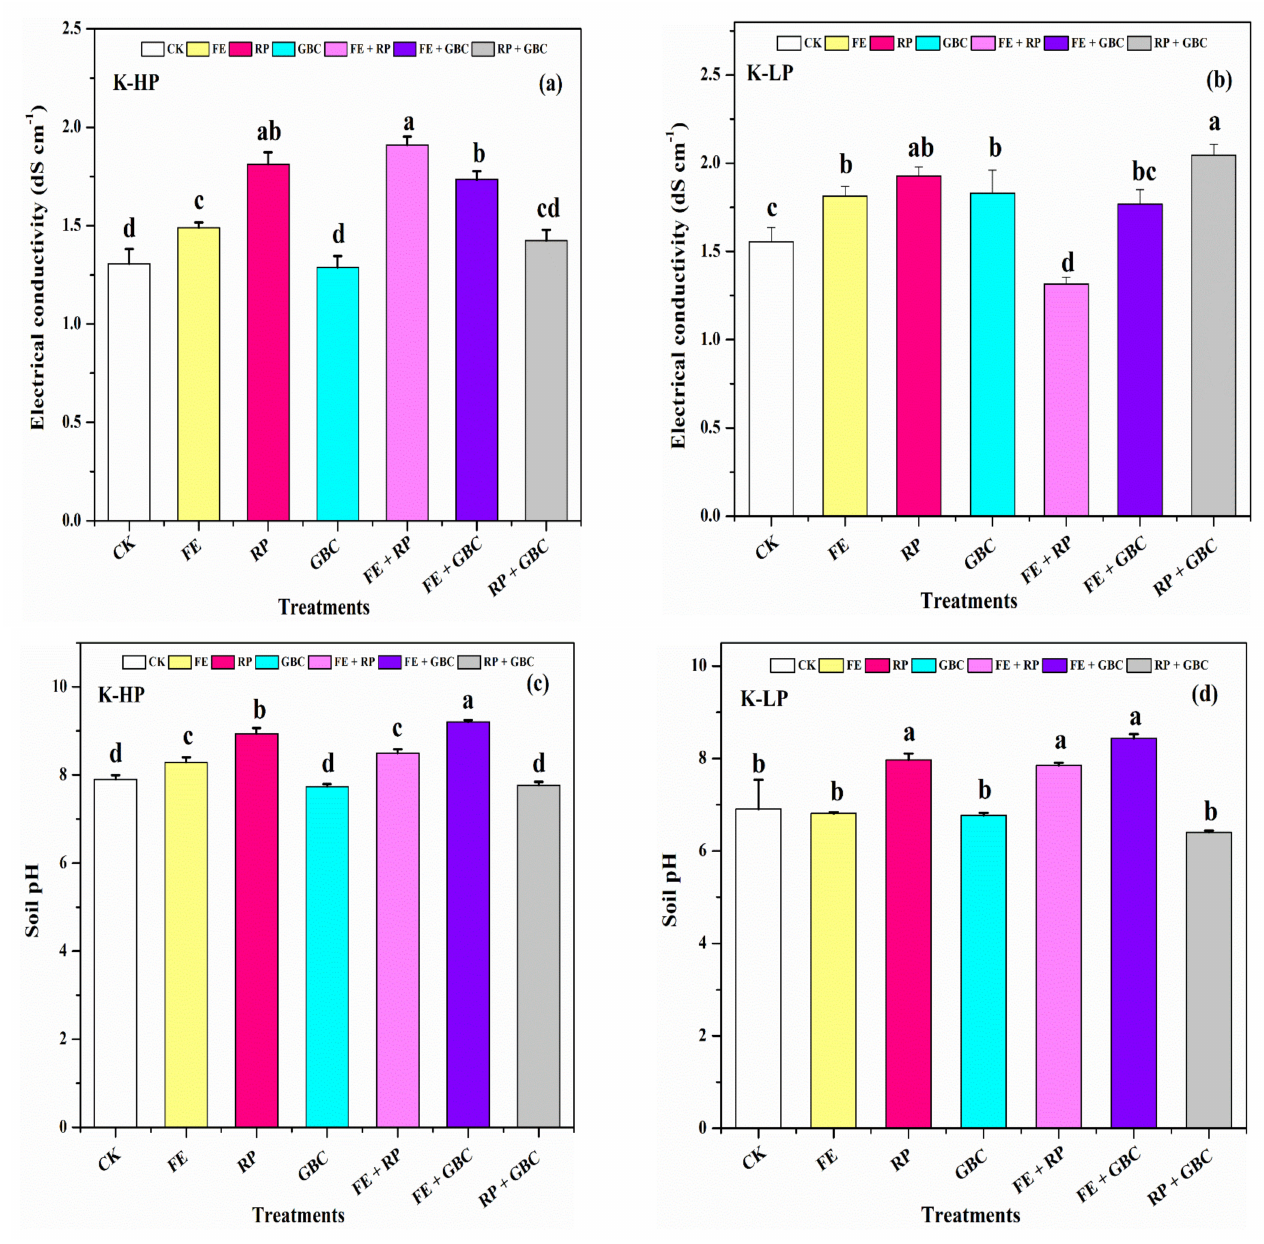
Figure 2. Influence of additives on electrical conductivity ( a ) in K-HP soil and ( b ) in K-LP soil; influence of additives on pH ( c ) in K-HP soil and ( d ) in H-LP soil. The values in a given column followed by the same letter are statistically not significantly ( p < 0.05) using Tukey’s HSD